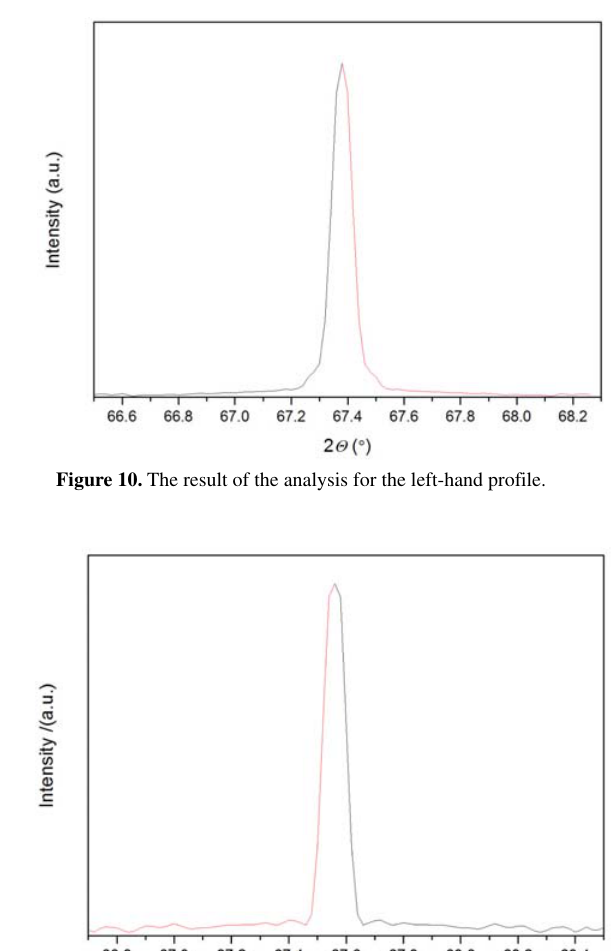
profile and its 2 nd derivative. 6